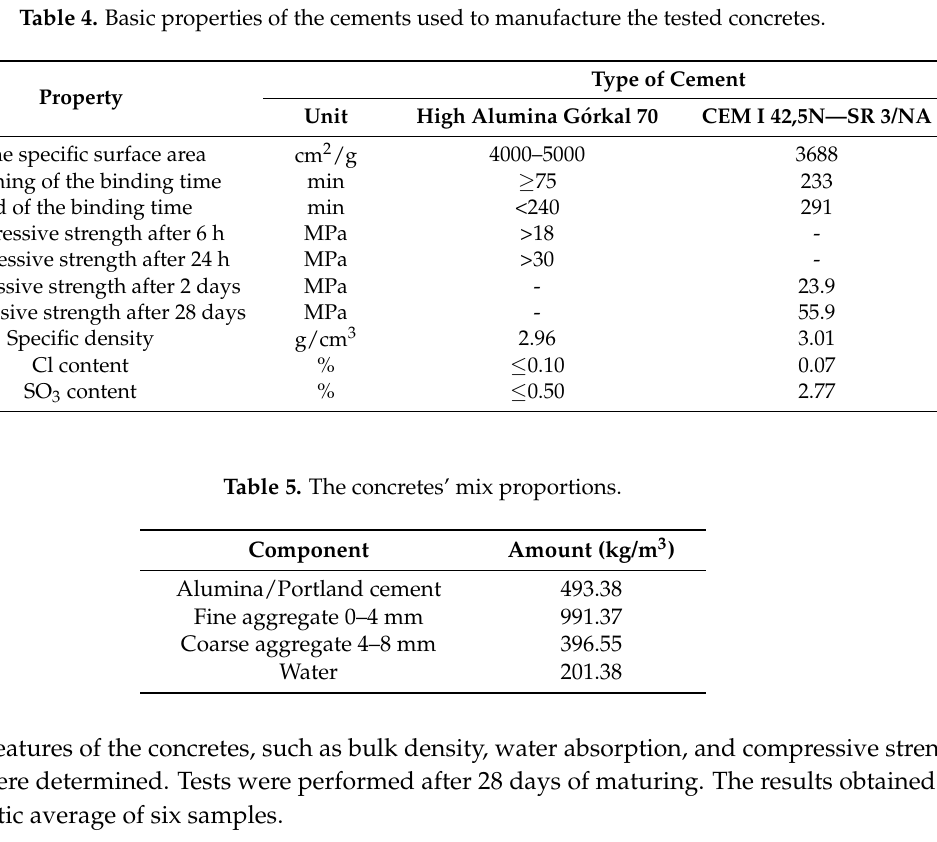
Table 6. Basic features of the concretes used in the